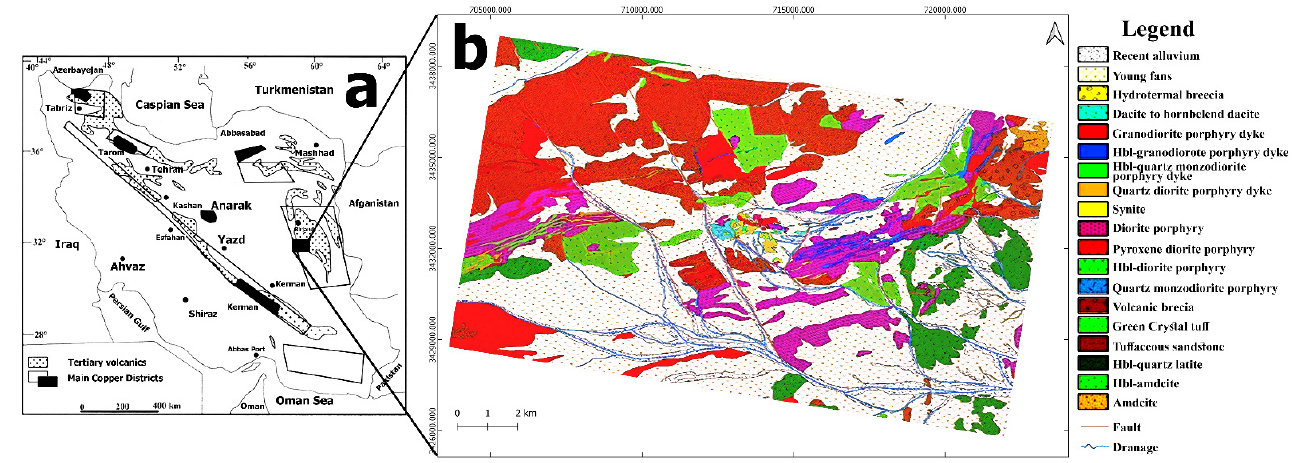
Figure 1. ( a ) Geographical location of Simorgh area in Iran; ( b ) Geological map of Simorgh area (World Geodetic System 1984 (WGS 84), UTM zone 40 N)